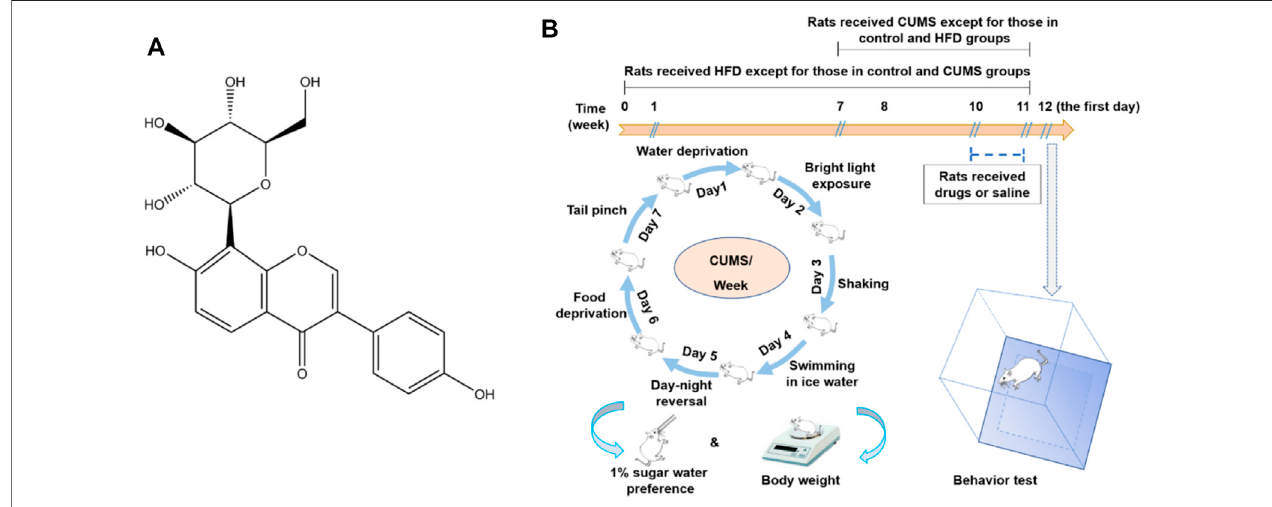
FIGURE 1 | Structure of puerarin (A) and a schematic diagram of the HFD/CUMS procedure, drug administration, and behavioral evaluation (B) .